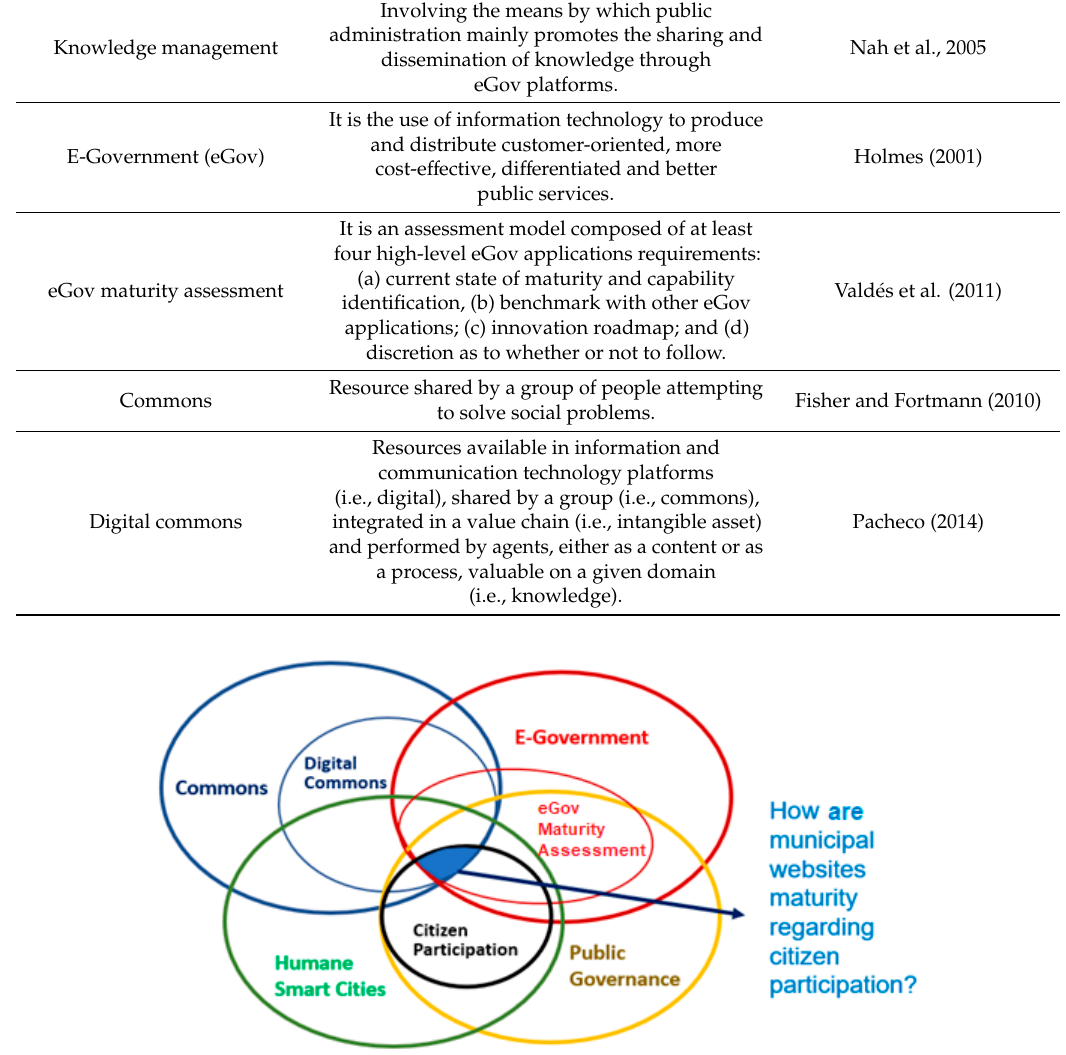
Figure 1. Research problem and conceptual constructs.